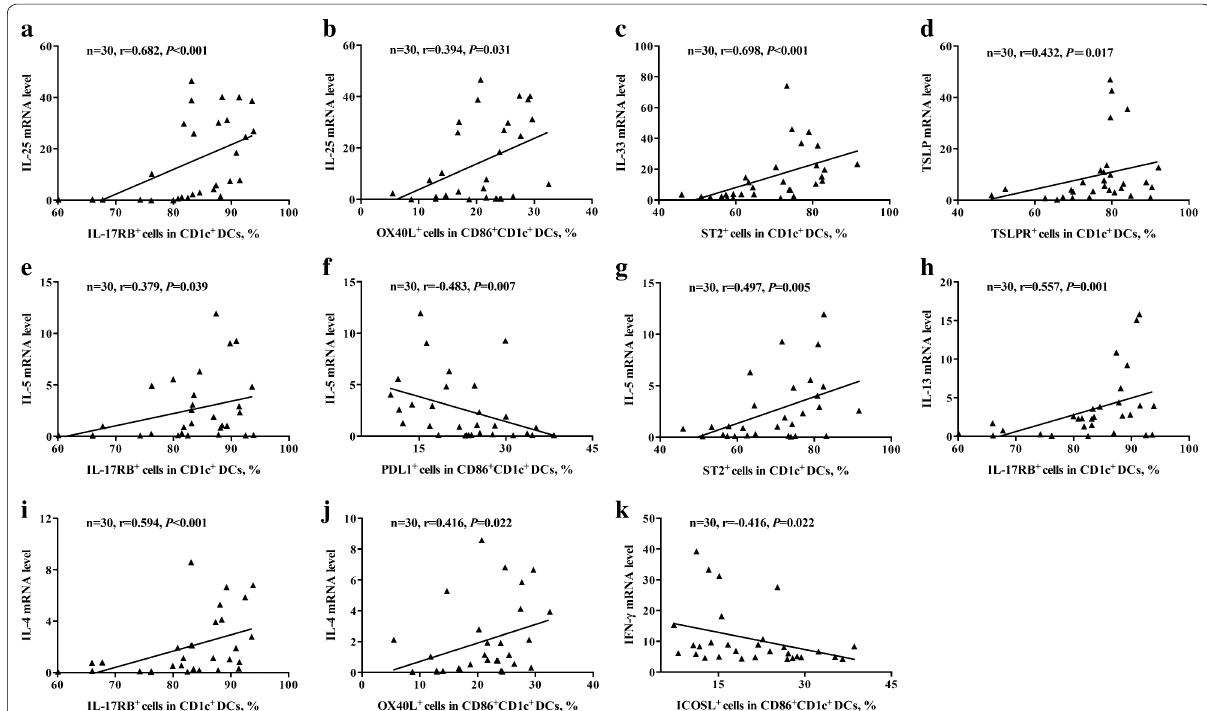
Fig. 5 Correlation of DC surface phenotypes with cytokine mRNA expression levels in NP tissue. Correlations of the mRNA levels of IL‑25 with the percentage of IL‑17RB on CD1c + DCs ( a ) and the percentage of OX40L on CD86 + CD1c + DCs ( b ), IL‑33 with the percentage of ST2 on CD1c + DCs ( c ), TSLP with the percentage of TSLPR on CD1c + DCs ( d ), IL‑5 with the percentage of IL‑17RB on CD1c + DCs ( e ), PDL1 on CD86 + CD1c + DCs ( f ) and ST2 on CD1c + DCs ( g ), IL‑13 with the percentage of IL‑17RB on CD1c + DCs ( h ), IL‑4 with the percentage of IL‑17RB on CD1c + DCs ( i ) and OX40L on CD86 + CD1c + DCs ( j ), and IFN‑γ with the percentage of ICOSL on CD86 + CD1c + DCs ( k ) in NP tissues